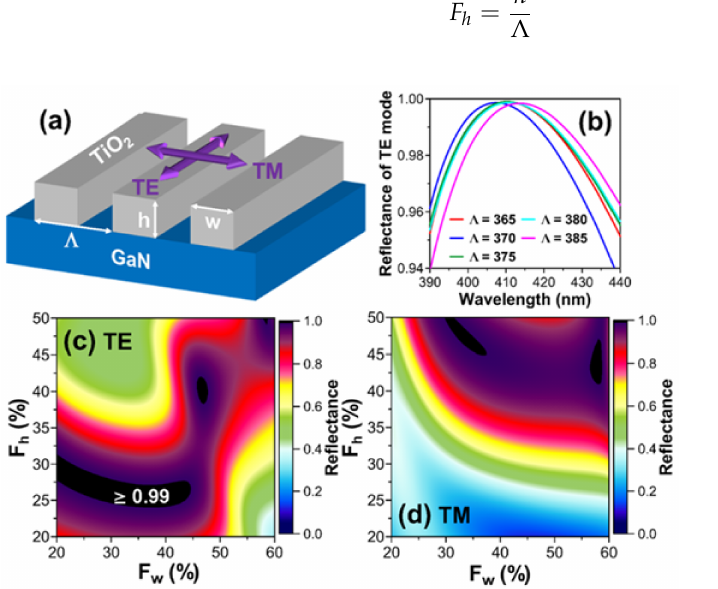
Figure 13. ( a ) Schematic illustration of TE-mode and TM-mode polarization in TiO 2 HCG on GaN ( b ) Reflectance spectrum of selected HCG structures. Reflectance mapping in the F w /F h parameter space with ( c ) TE-mode and ( d ) TM-mode